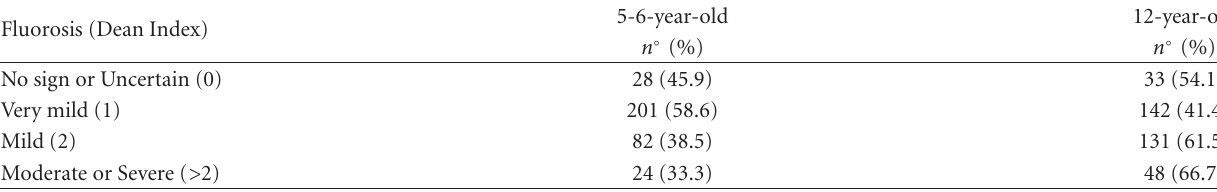
Table 2: Fluorosis levels in the two-age sample (percent in